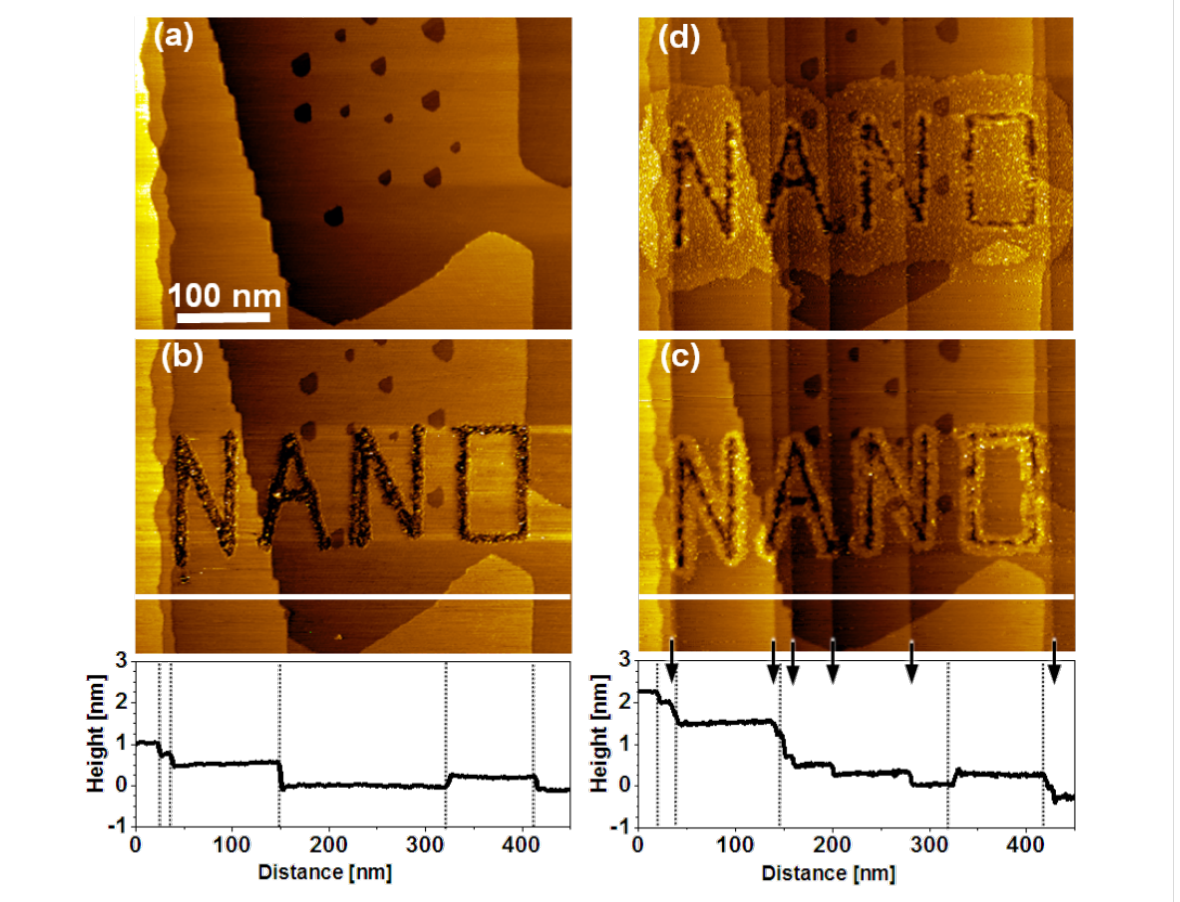
Figure 4: Templated Cu-UPD illustrating tolerance of the process against substrate dislocations. (a) Native substrate with uniform BP2 SAM. (b) Lithographic pattern formed in air by using a tip bias of 4.2 V and a tip speed of 0.75 μ m/s. (c) EC-STM images of Cu-UPD after 11 min at 0.16 V vs Cu 2+ /Cu. (d) Uniform UPD area after 32 min. Dotted lines and arrows in height profiles along lines shown in (b,c) mark substrate steps present in the native substrate and generated during UPD,